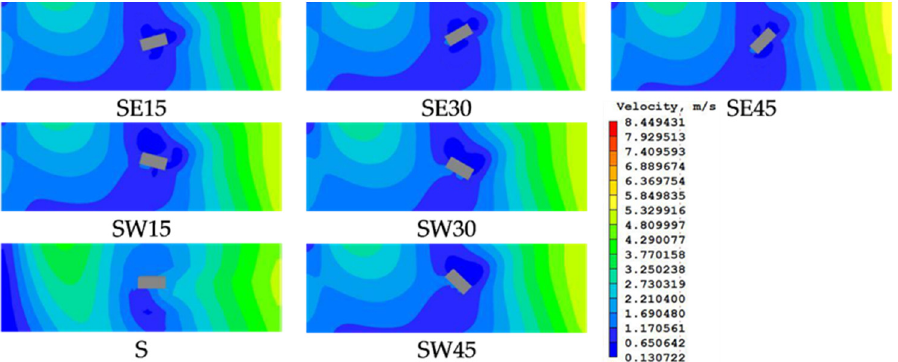
Figure 14. The effects of orientation on the wind conditions.